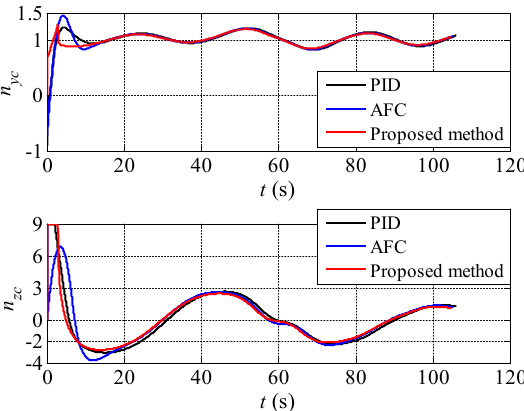
Figure 13. The actual control overloads of the UCAV during the process of attack guidance.